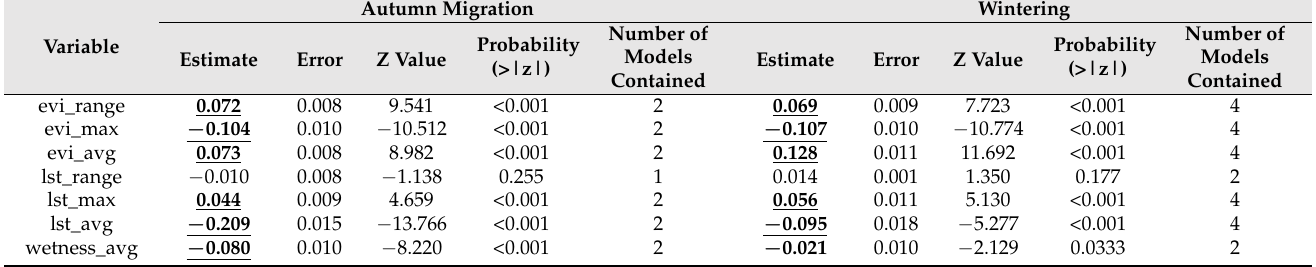
Table 2. Generalized linear mixed model (GLMM) results for the autumn migration and wintering periods. Estimate of regression coefficients results from an averaged model obtained from those with delta AIC < 4. The importance of each ecosystem functioning variable (last column) is represented by the number of times that each variable appears contained in the explanatory models (delta AIC < 4). EFAs: EVI—enhanced vegetation index; TCTwet—tasseled cap transformation—water component; LST— land surface temperature; respective maximum (max), minimum (min), average (avg), and range (range) values. Šid á k’s correction [81] was computed to adjust p-values for multiple comparisons. Significant results, at p < 0.05, are shown in bold and underlined if significant after correction for seven